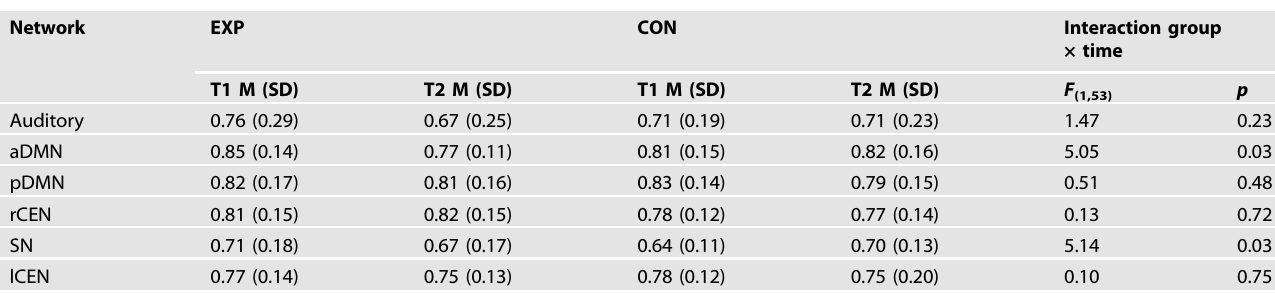
Table 4. ANOVA for integrity of fMRI-based networks.